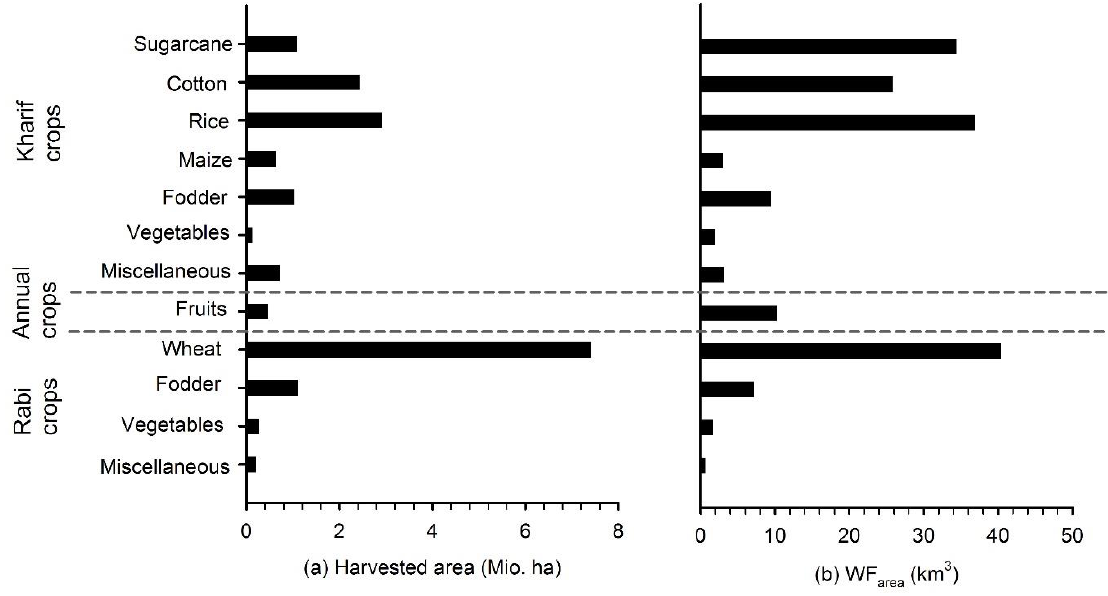
Figure A1. ( a ) Harvested area; and ( b ) WF area of crop production for the baseline year 2016.